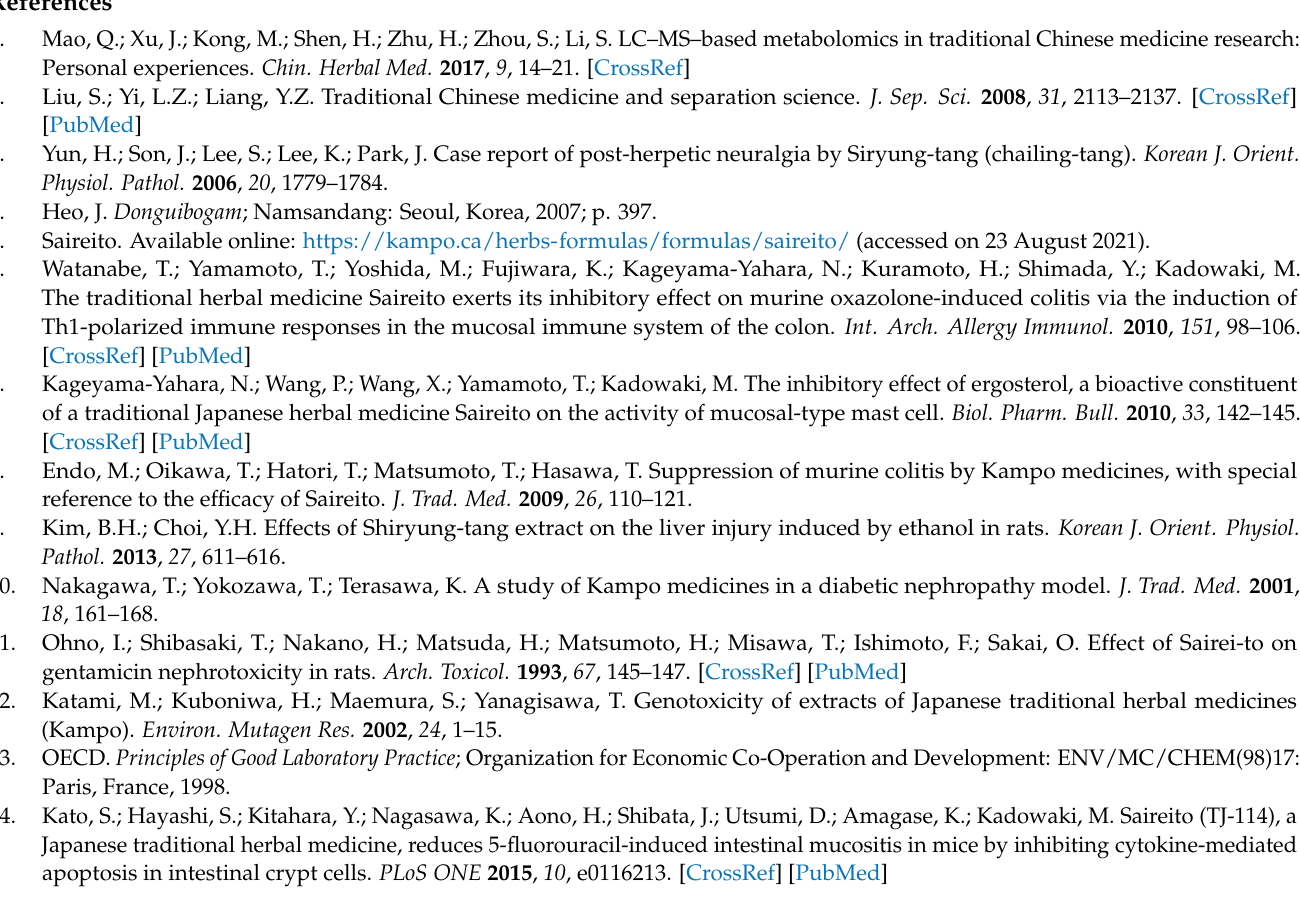
Table S2: Repeatability of the retention times for the 12 markers determined using HPLC ( n = 6). Table S3: Repeatability of the peak areas for the 12 markers determined using HPLC ( n = 6). Table S4: Information about SRT and its composition. Table S5: HPLC analysis conditions for simultaneous determination of the 12 marker components in